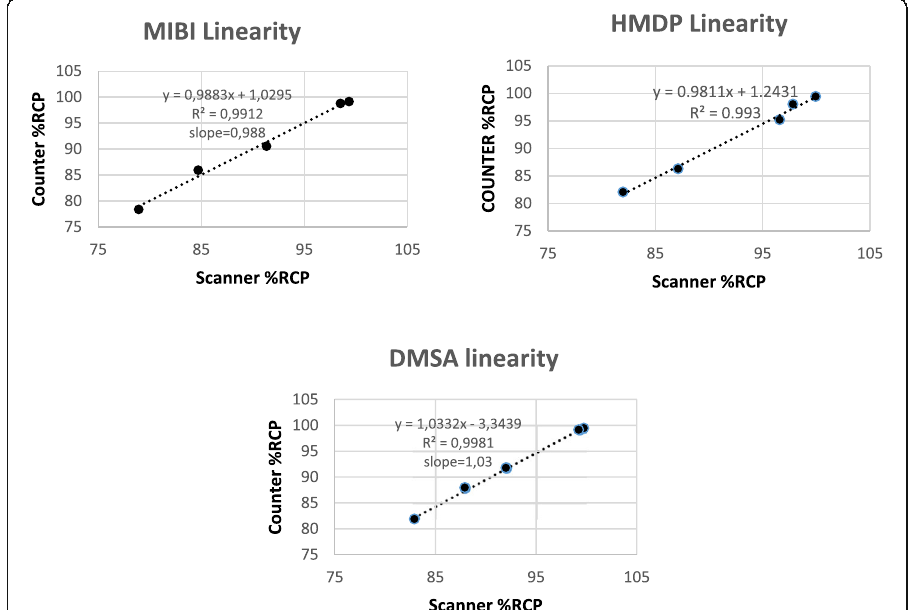
Fig. 3 Linearity of the proposed method for the 3 products, counter response compared with RCP values determined with the